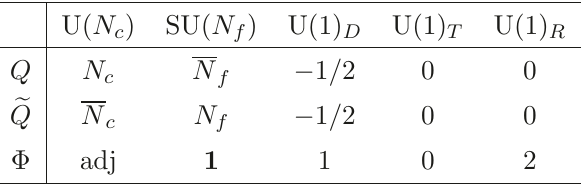
Table 4 . Matter contents of the 3d N = 2 ∗